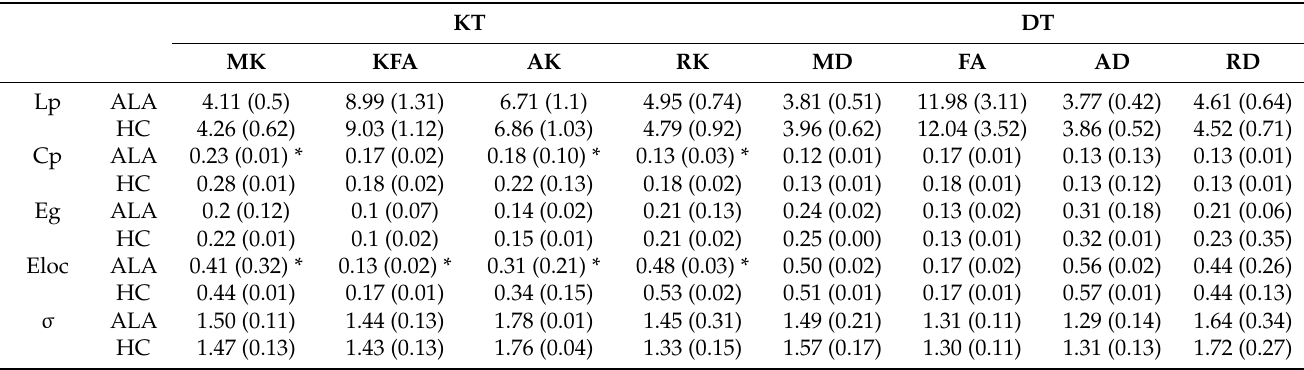
Table 2. Altered small-world characters of DKI metrics of the white matter network between the ALA and control groups.